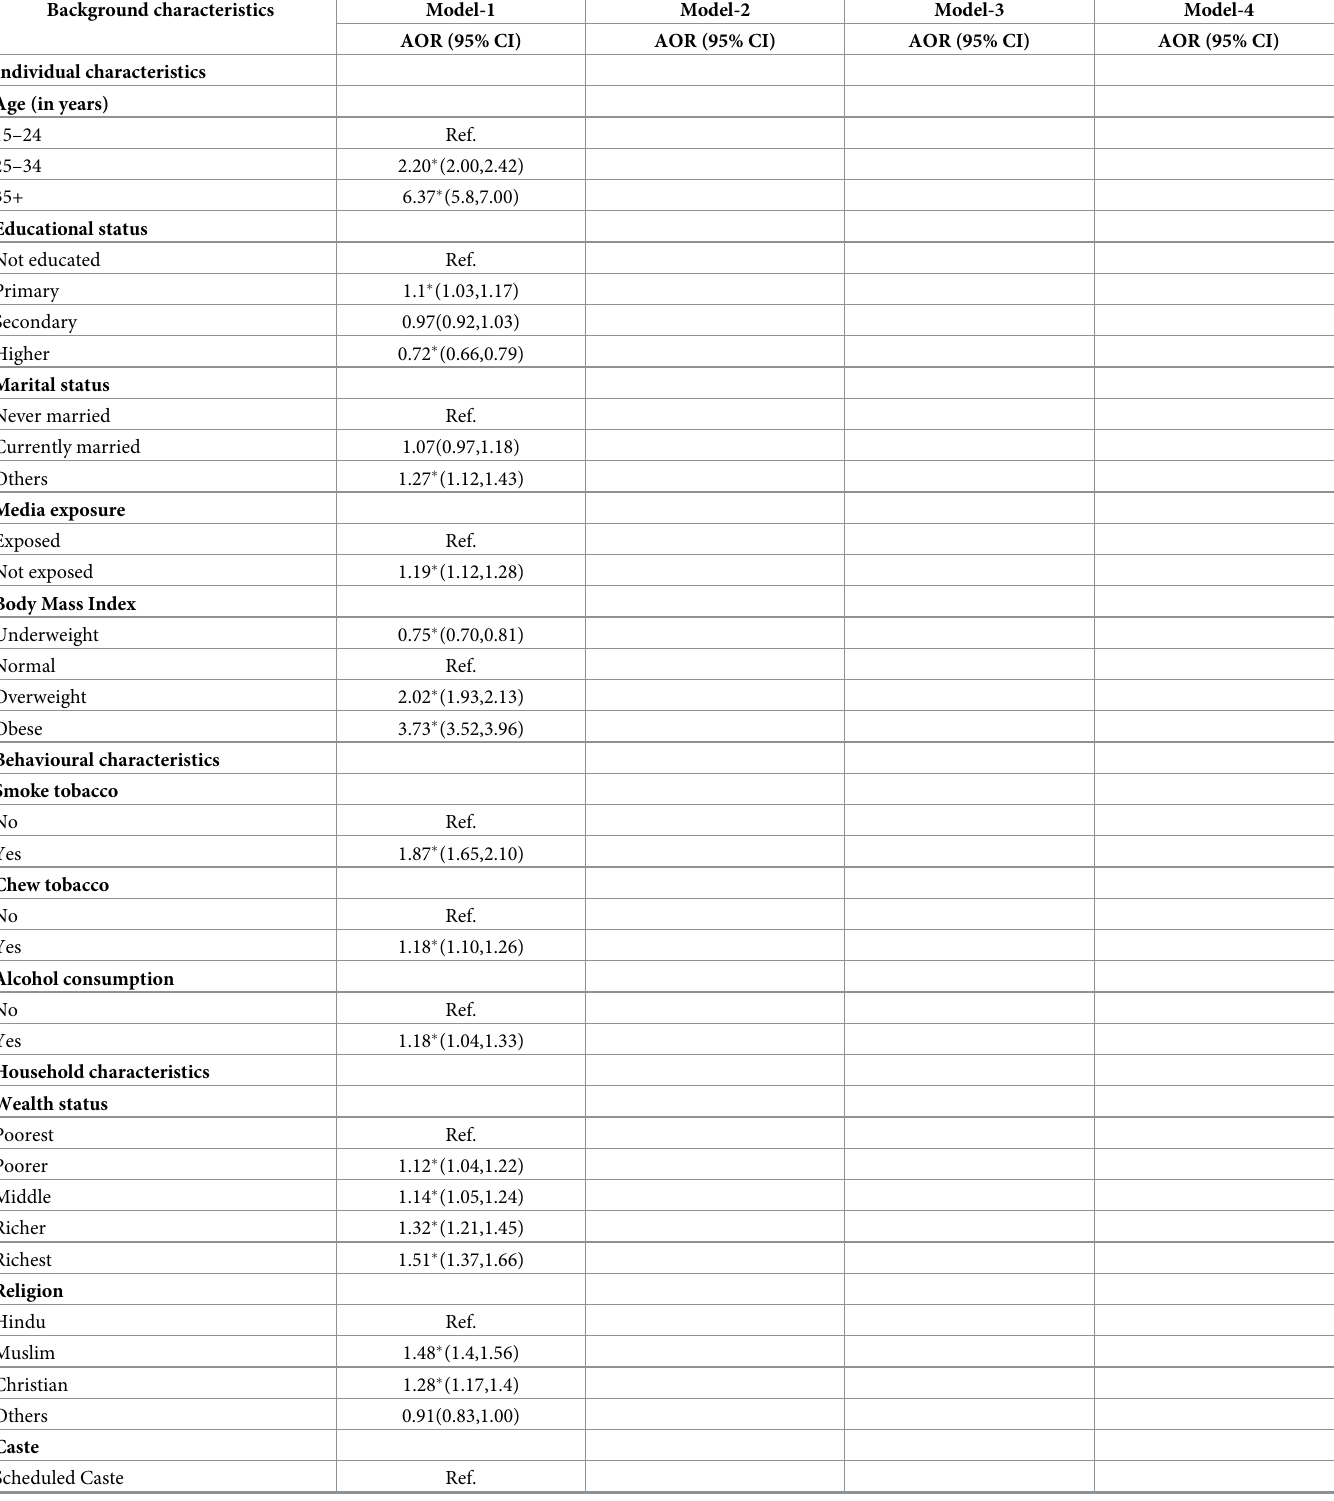
Table 3. Logistic regression estimates for multi-morbidity among women aged 15–49 years in India,